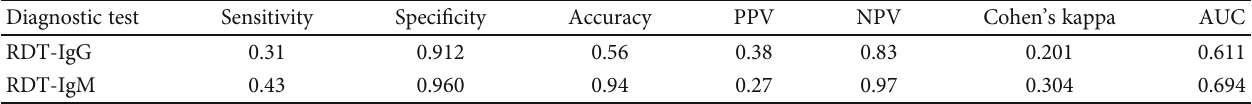
Table 4: Diagnostic performance of T . gondii RDT-IgG and RDT-IgM diagnostic tests against the ELISA technique. Diagnostic test